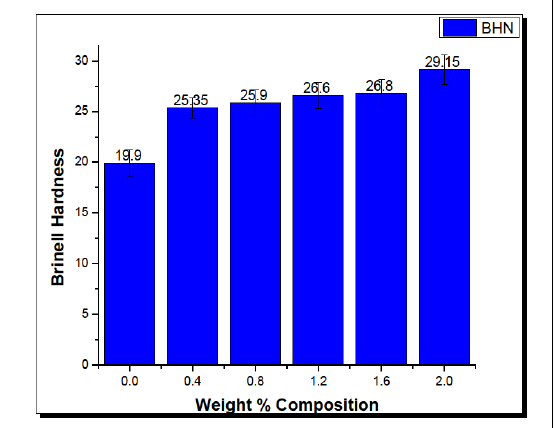
Figure 11: Impact Energy of the graphite nano-particulate reinforced brass composites. Source: Authors, (2022).